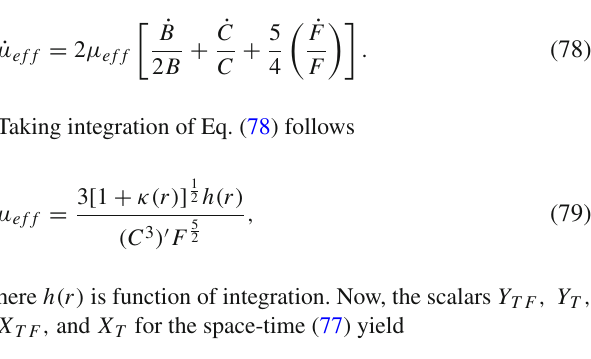
Fig. 1 Plots of C versus t and r for κ = − 0 . 5 and m = 1 . 4, indicating the open universe increasing exponentially with the passage of time